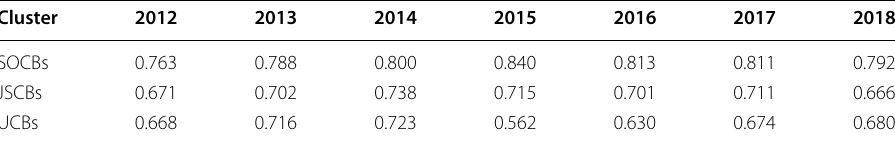
Table 6 Overall Efficiency of Each Cluster from 2012 to 2018